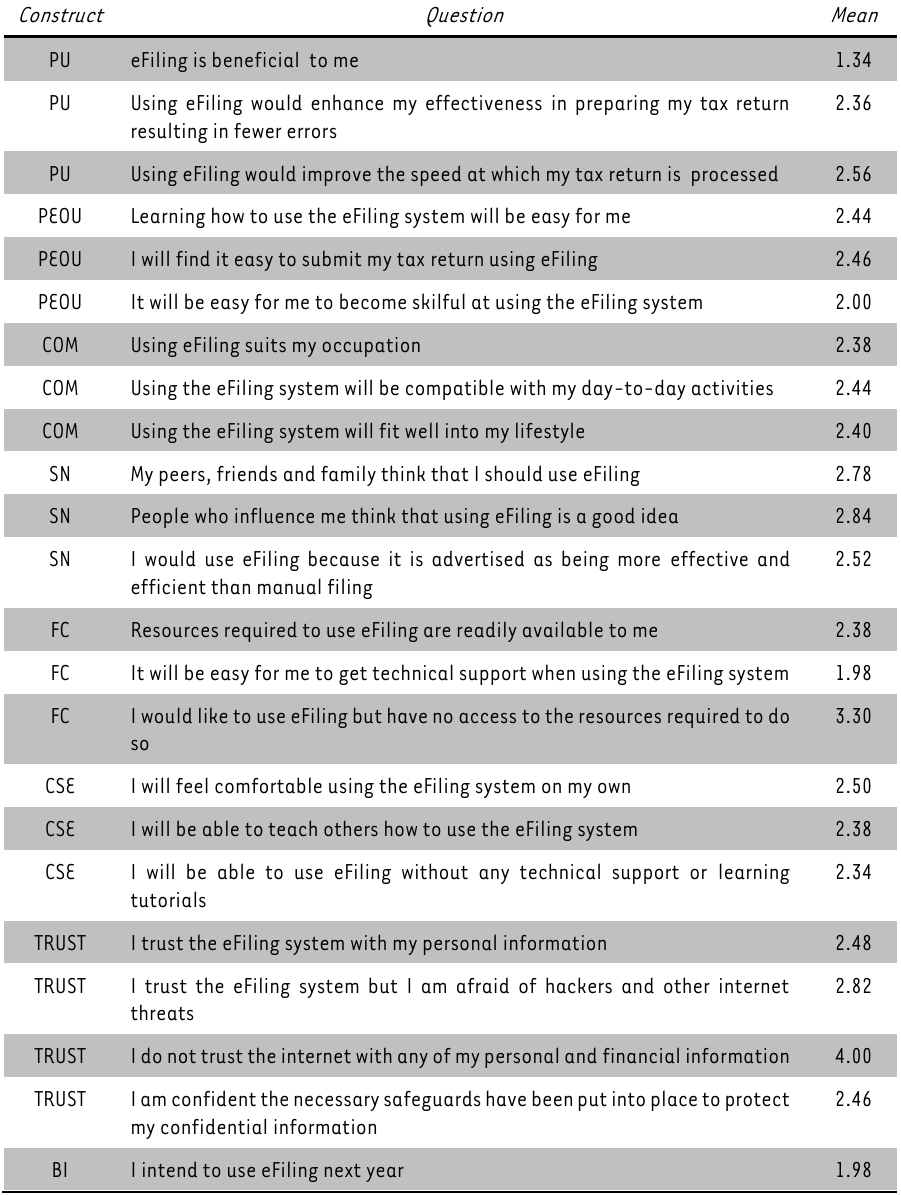
TABLE 2: Questions and results for manual tax filers